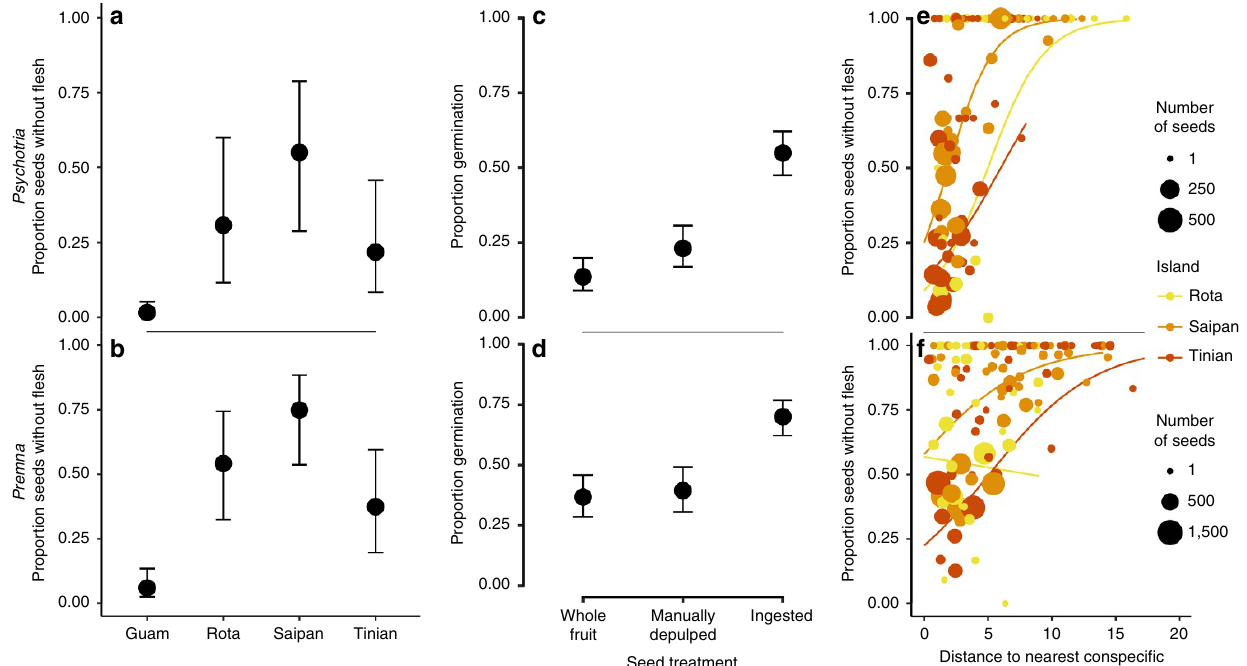
Figure 2 | Fruit ingestion by birds. Proportion of seeds in seed traps lacking fruit flesh on Guam (no birds) and on Saipan, Tinian and Rota (with birds), as predicted from generalized linear mixed effects models, for Psychotria ( a ) and Premna ( b ). The difference between the proportion of seeds without flesh on Guam and that on islands with birds is attributable to bird consumption. Psychotria ( c ) and Premna ( d ) seeds that have been ingested by birds are more likely to germinate than those that have not, as predicted by generalized linear mixed effects models, and manual flesh removal does not have the same impact as seed ingestion. The proportion of seeds in traps lacking fruit flesh on Rota (yellow), Saipan (light orange) and Tinian (dark orange) is related to the distance to the nearest conspecific for both Psychotria ( e ) and Premna ( f ). Each point represents a single seed trap, and point size indicates the total number of seeds found in that trap. Model predictions by island are indicated by the lines, limited to the range of distances observed on each island. All error bars represent 95% confidence intervals around model